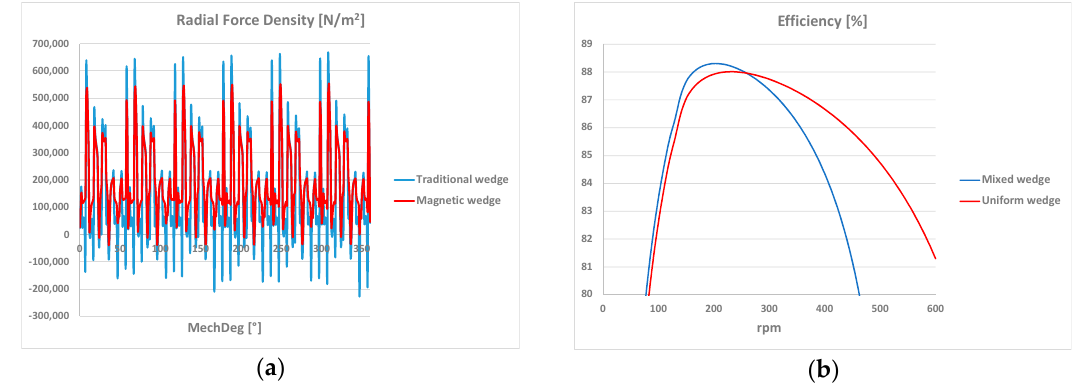
Figure 16. ( a ) Radial component of the radial force density acting on the internal stator surface; ( b ) Electromagnetic torque at a variable speed.